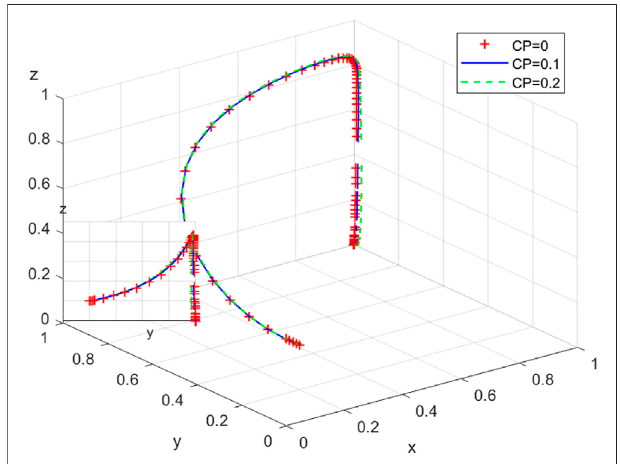
FIGURE 9 | Impact of the reward amount set by LGs for CP on the evolution track of the tripartite evolutionary game.